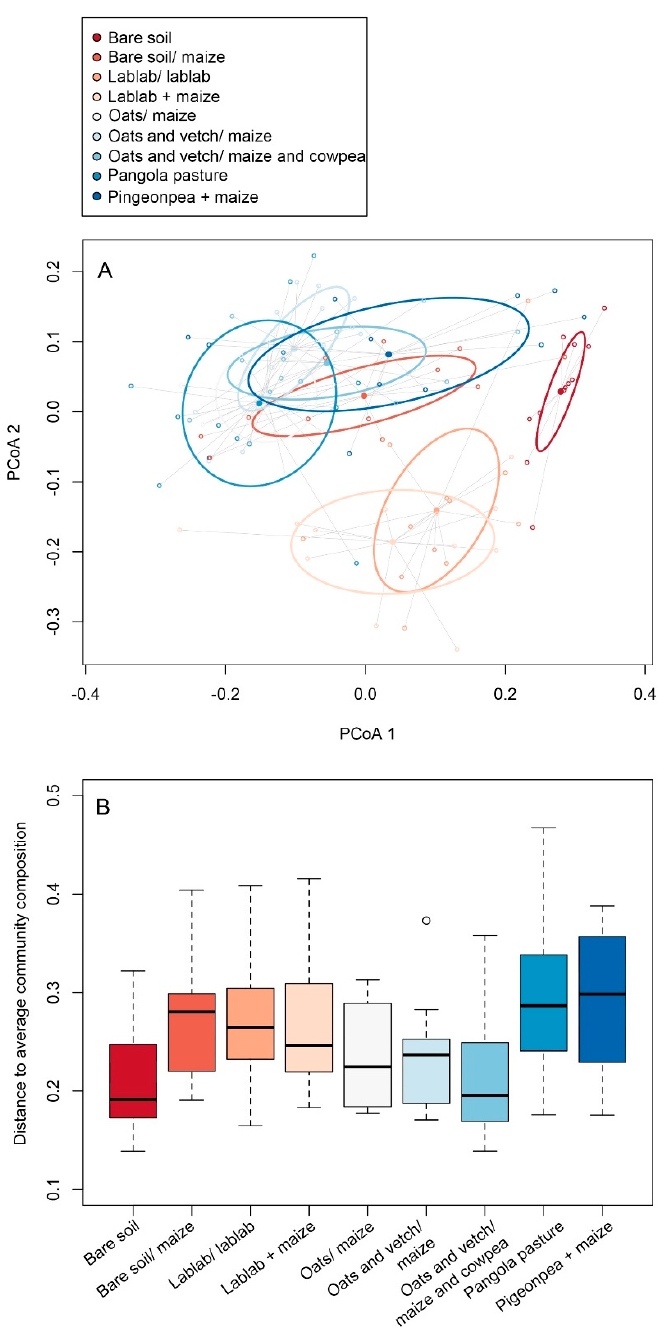
Figure 5 A and B. Dissimilarity indices among the soil microbial community composition across eight different management regimes. Panel A represents a Principal Coordinates Analysis (based on a Bray-Curtis dissimilarity matrix) across eight different planting treatments, with ellipses corresponding to 95% confidence intervals surrounding treatment-specific centroids. In this Principal Coordinates Analysis, average distances to the global centroid were largest for the Pangola pasture treatments (average Euclidean distances to centroid = 0.293) and lowest for fallow treatments (average Euclidean distances to centroid = 0.208). Boxplots in Panel B represent summaries of treatment-specific distances to an overall mean centroid calculated for all data points. First, the community composition of all samples derived from the bare soil treatment separate from all other treatments along the first principal coordinate / RDA axis (Figure